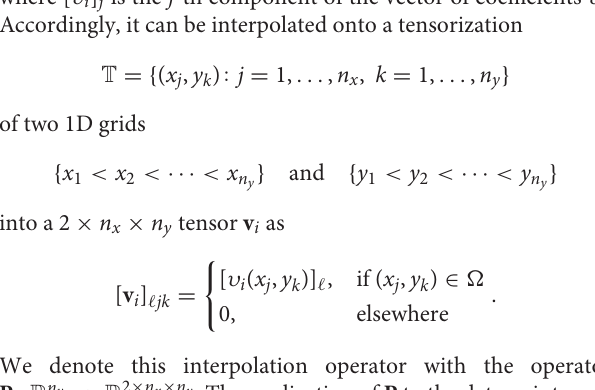
be the ansatz space of the finite element